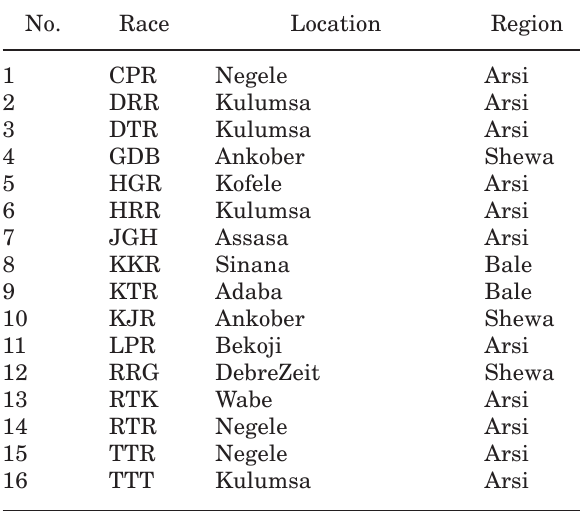
Table 1. Races of Puccinia graminis f. sp. tritici in the Arsi, Bale and Shewa regions of Ethiopia in 2001.